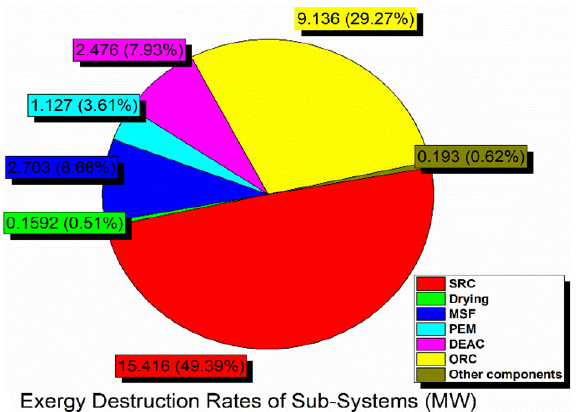
Figure 5. Exergy destruction pie diagram in the various subsystems of the integrated